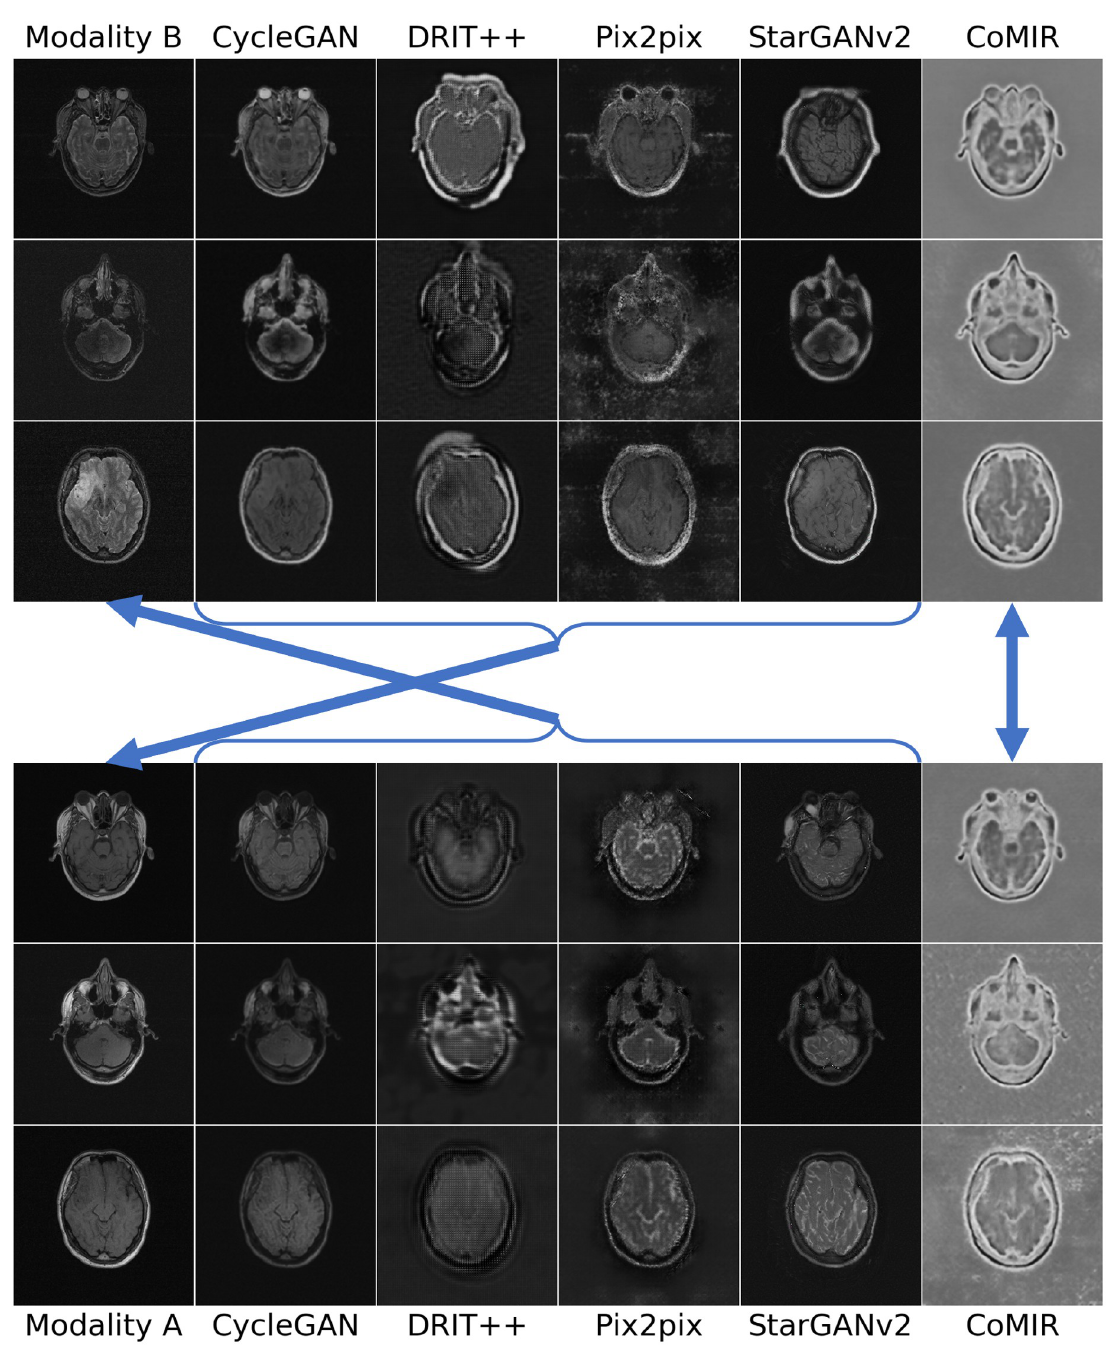
Fig 7. Modality-translated image samples of the Radiological dataset by different evaluated methods. Each row shows the results on one random slice from each fold. Images in Columns 2–6 are generated from the images in the corresponding row of Column 1. Top block: Translations generated from Modality B. Bottom block: Translations generated from Modality A. The arrows indicate what to compare for visual inspection of the level of achieved similarity (pointing from generated images to the corresponding target of the learning